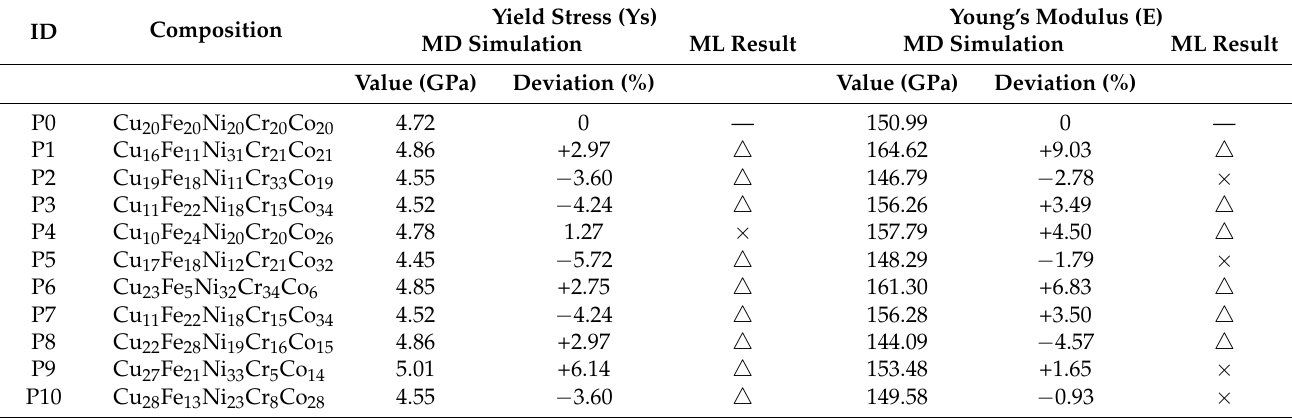
Table 2. Comparison of MD simulation and ML prediction for yield stress and Young’s modulus of ten polycrystal HEA samples. x% represents the deviation of the values between the non-equiatomic samples (P1–P10) and the equiatomic sample (P0). ‘ (cid:52) ’ represents that the ML prediction is consistent with the MD simulation; otherwise, the ML result is marked as ‘ ×